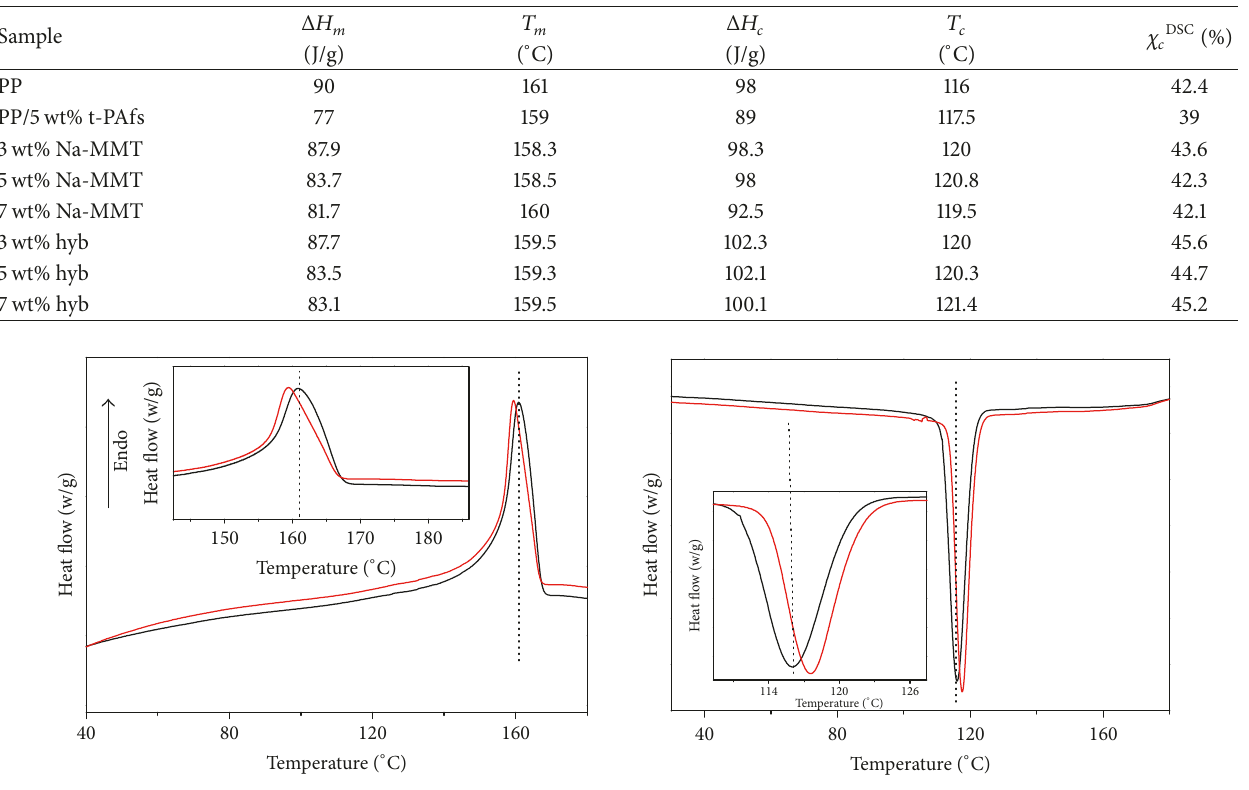
Table 3: Melting ( 𝑇 𝑚 ), crystallization temperatures ( 𝑇 𝑐 ), and enthalpies ( Δ𝐻 𝑚 , Δ𝐻 𝑐 ) for different samples and crystallinity degree ( 𝜒 𝑐 ) obtained by DSC.